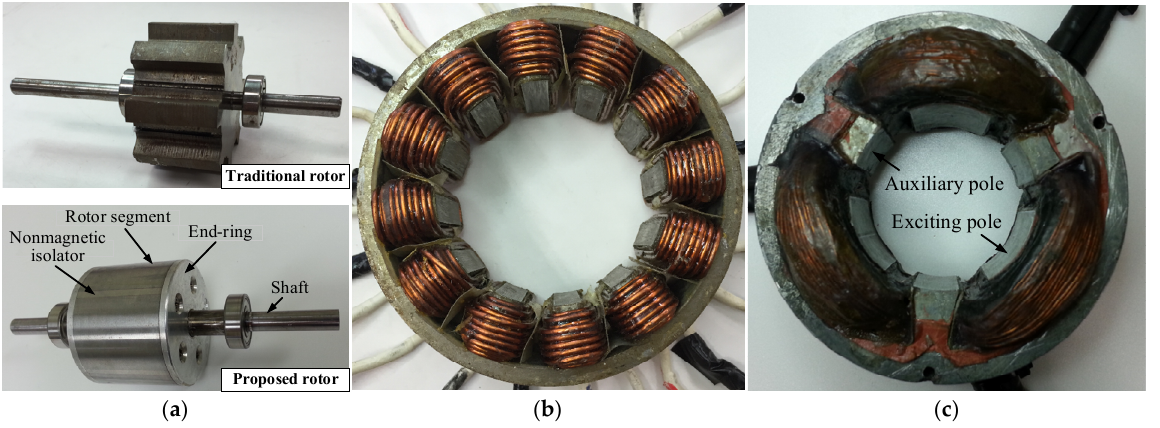
Figure 15. Prototypes of traditional and proposed SRMs. ( a ) Rotor of traditional 12/8 and proposed 6/5 SRMs; ( b ) Stator of traditional 12/8 SRM; ( c ) Stator of proposed 6/5 SRM.